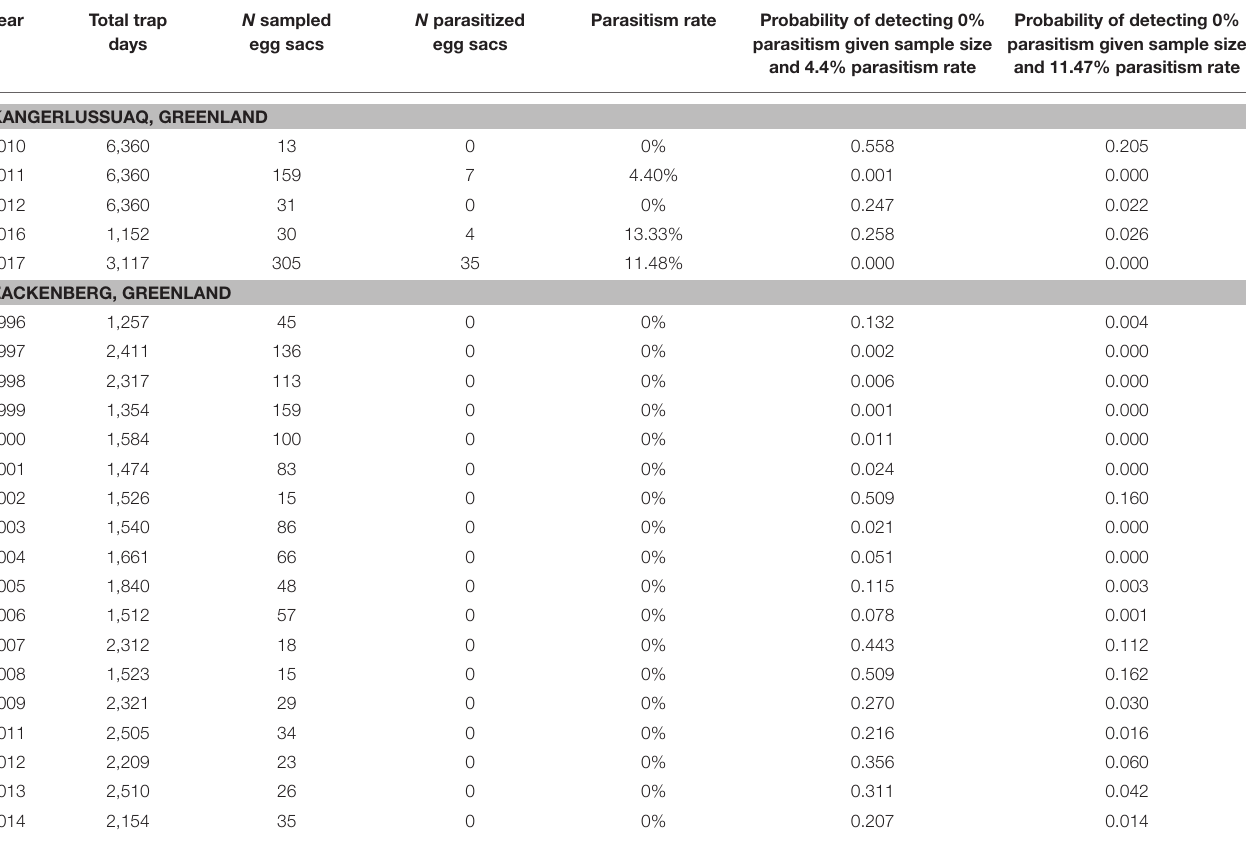
TABLE 1 | Number of sampled wolf spider ( Pardosa glacialis) egg sacs and egg sac parasitism rates for each study year from the Greenland sites of Kangerlussuaq (southern site) and Zackenberg (northern site). N sampled N parasitized Year Total trap Parasitism rate Probability of detecting 0% Probability of detecting 0% days egg sacs egg sacs parasitism given sample size parasitism given sample size and 4.4% parasitism rate and 11.47% parasitism rate KANGERLUSSUAQ,